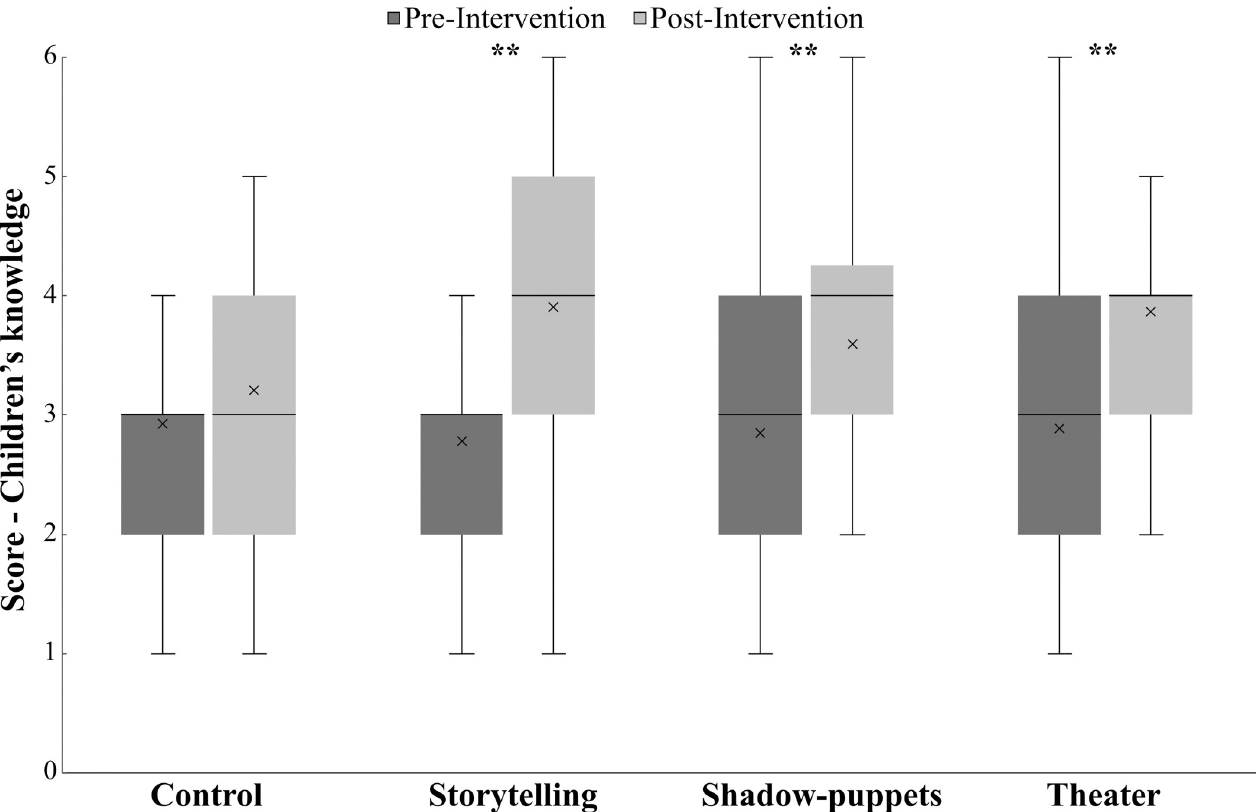
Fig 4. Changes in children’s knowledge between pre-and-post intervention with each arts-based educational techniques and control group. Lines outside the box represent min and max values. Within the box, the X symbol represents the median and horizontal lines represents the mean. https://doi.org/10.1371/journal.pone.0228382.g004 PLOS ONE | https://doi.org/10.1371/journal.pone.0228382 February 4,